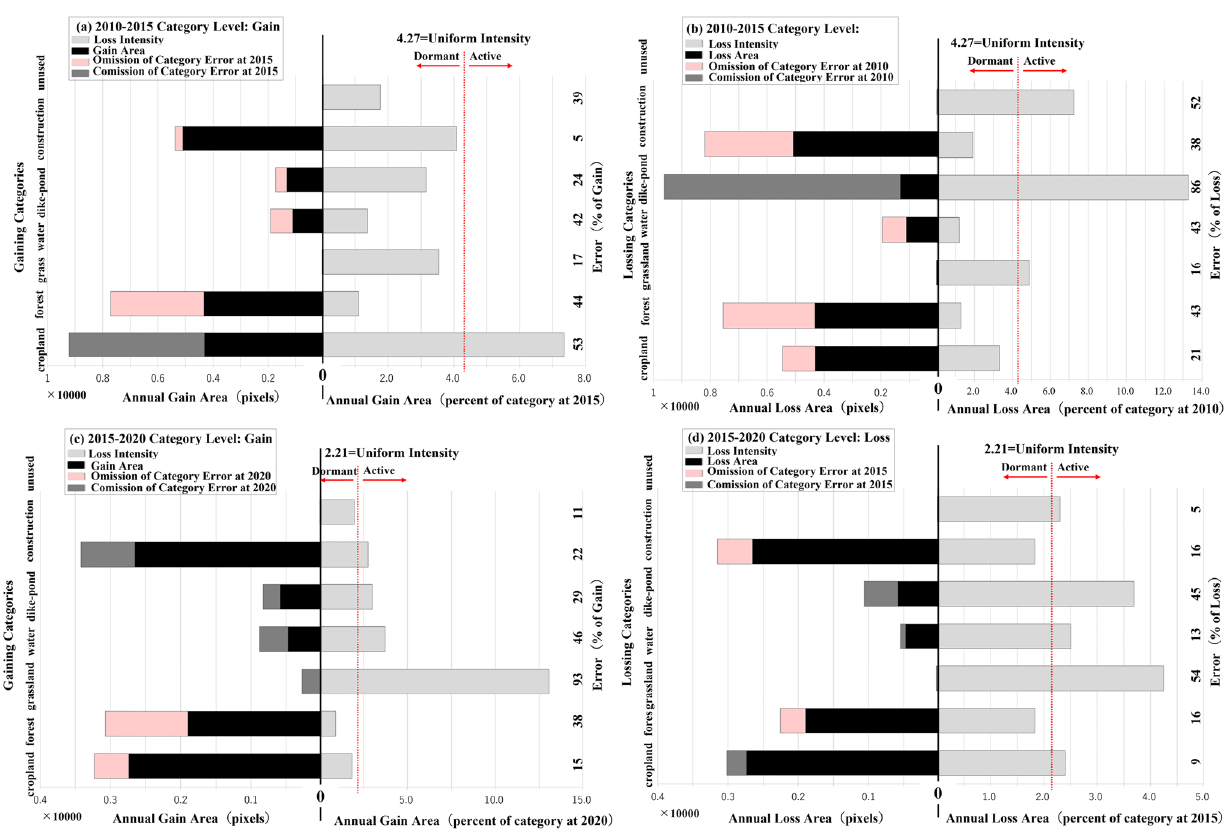
Fig. 8 The intensity changes of the category level in Foshan from 2010 to